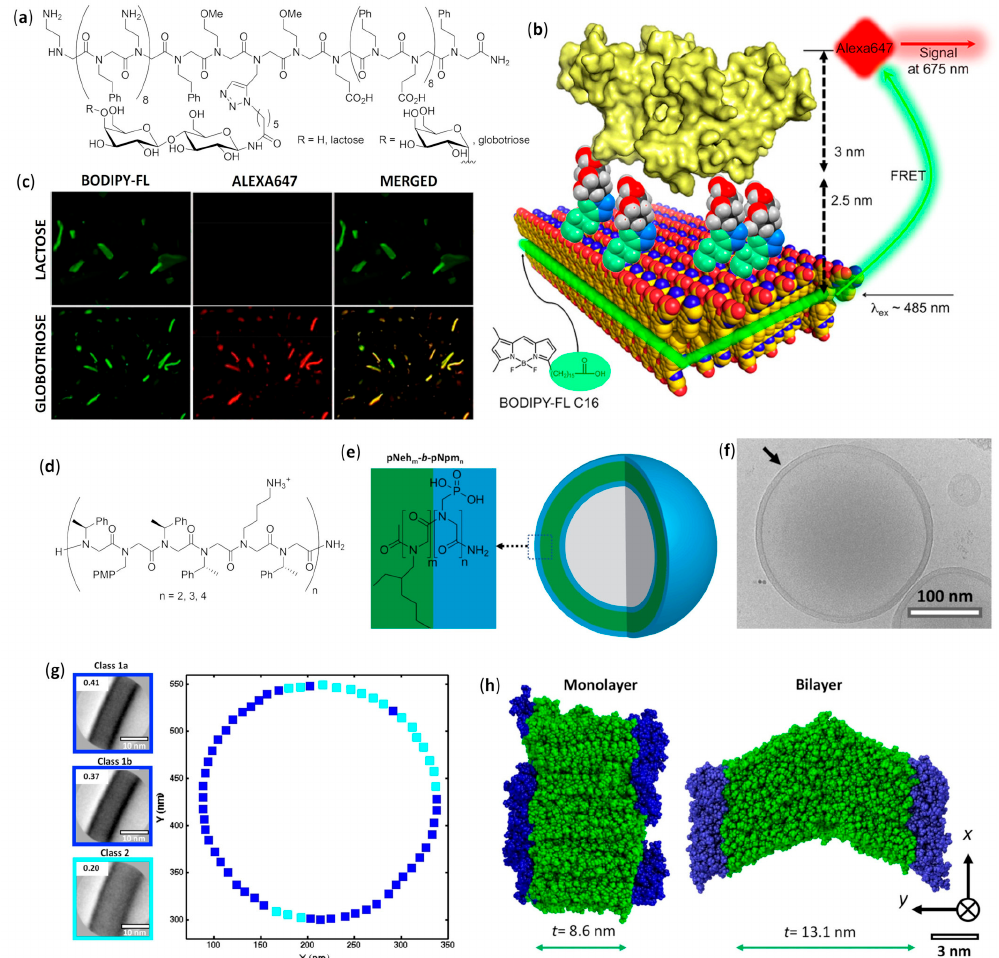
Figure 21. ( a ) Structures of peptoids bearing lactose and globotriose ligands (Ref. [240]); ( b ) Molecular model of lectins (yellow molecular surface) binding to peptoid nanosheets displaying carbohydrate ligands and FRET-based assay—BODIPY-FL C16 forms a layer between the two peptoids layers, which are arranged in parallel rows and display carbohydrates on the surface (unnecessary hydrogens omitted for clarity, carbons are in yellow, oxygens in red, and nitrogens in blue; lectin represented as yellow molecular surface); binding of lectins is detected by the emission of Alexa647 after FRET between BODIPY-FL C16 and Alexa647 (adapted with permission from Ref. [240]); ( c ) Fluorescence images of peptoid nanosheets functionalized with lactose and globotriose after incubation with Alexa647-conjugated Stx1B, showing the selective binding to the globotriose-functionalized peptoid nanosheet (adapted with permission from Ref. [240]); ( d ) Example of microsphere-forming peptoids (PMP = p -methoxyphenyl) (Refs. [241–243]); ( e ) General structure of amphiphilic di-block polypeptoids, with the hydrophilic (blue) and hydrophobic (green) blocks, and vesicle formed (adapted with permission from Ref. [244]); ( f ) Cryo-EM micrograph of pNeh 26 - b -pNpm 10 vesicles (the arrow indicates the vesicle analyzed in panel ( g )) (adapted with permission from Ref. [244]); ( g ) Averaged cryo-EM micrographs of boxes extracted from the vesicle in panel ( f ), formed by pNeh 26 - b -pNpm 10 , with the classification according to the thickness in that membrane portion (classes 1a and 1b, both grouped in class 1, are ~10 nm; class 2 is ~12 nm). The probability of finding each class in the vesicle is given in the related boxes, and the disposition of class 1 (dark blue) and class 2 (cyan) boxes in the membrane of the vesicle in panel ( f ) is also shown (adapted with permission from Ref. [244]); ( h ) Relaxed simulation of monolayer (left, interdigitated hydrophobic chains) and bilayer membranes (right, non-interdigitated hydrophobic chains), with the corresponding hydrophobic core thickness, t (peptoid blocks color-coded as in panel ( e ), side chains and water molecules omitted for clarity) (adapted with permission from Ref.